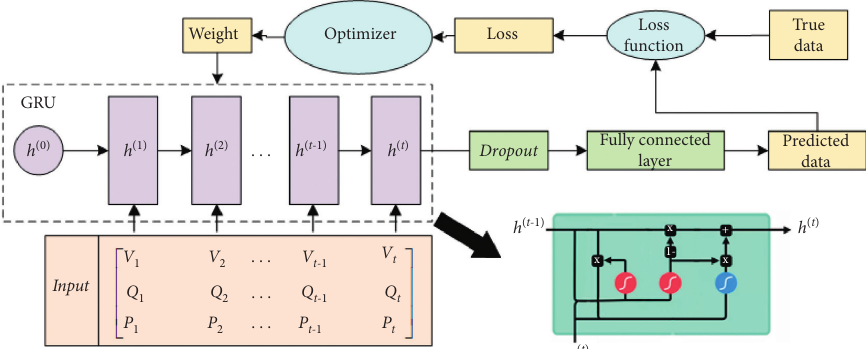
Figure 4: Structure of the GRU prediction